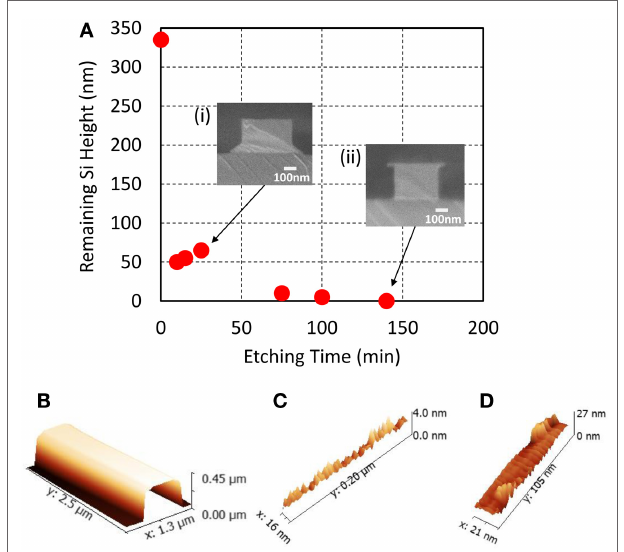
FigUre 3 | (a) Remaining silicon thickness as a function of time. Different patterned SOI samples were used to estimate the remaining Si height for different etching time. As one can notice initially the etch rate is quite fast, but at the end due to the presence of a semi-stable crystal plane, a long etch time was needed to completely remove the silicon around the waveguide. Inset (i) shows the waveguide cross-section with the presence of semi-stable plane after 10 min etching time. Inset (ii) shows the waveguide cross-section after 140 min of etching time. (B) AFM image of a silicon waveguide fabricated using wet etching process. (c) Close up view of the surface reveals a RMS roughness of 1.2 nm. (D) AFM image of a silicon waveguide fabricated using dry etching process with RMS roughness of 7